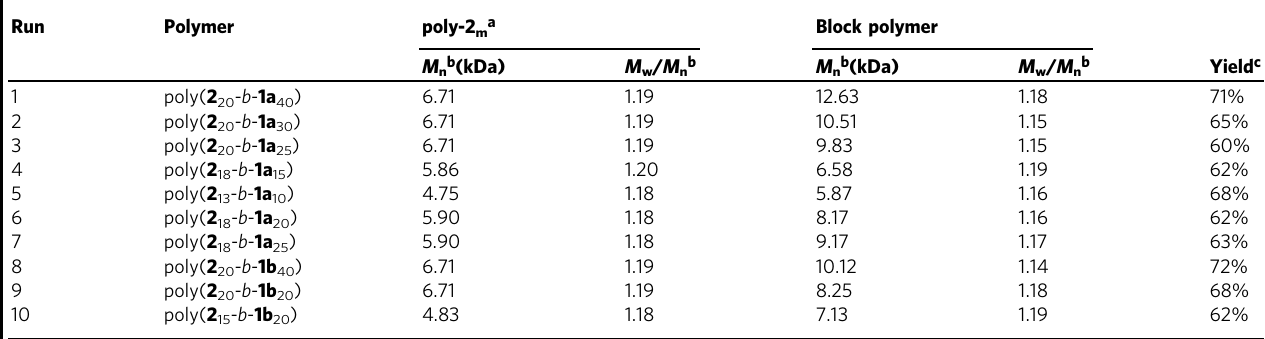
Table 2 Characterization for P3HT- b -polycarbene copolymers. Run Polymer